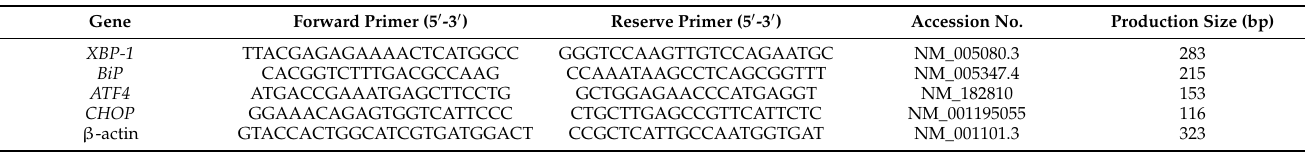
Table 1. Primers for RT-qPCR of ER stress regulatory